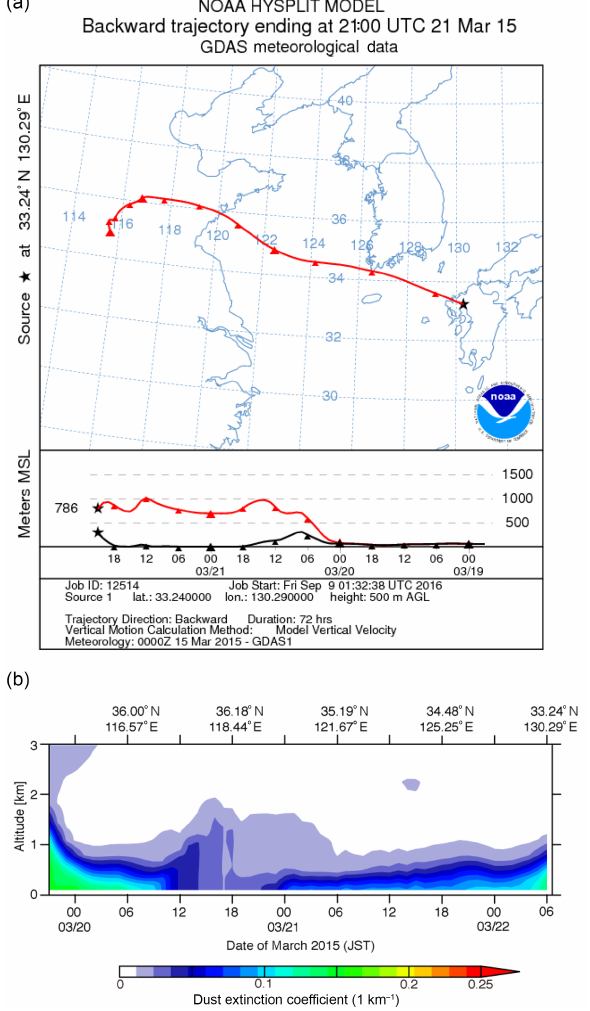
Figure 8. (a) The 72h HYSPLIT-model backward trajectory (red line) and terrain height (black line) from Saga at 1500m above ground level (a.g.l.) ending at 06:00JST on 22 May 2015. (b) Time– altitude cross section of dust extinction coefficient simulated by the MASINGAR mk-2 along the trajectory path.